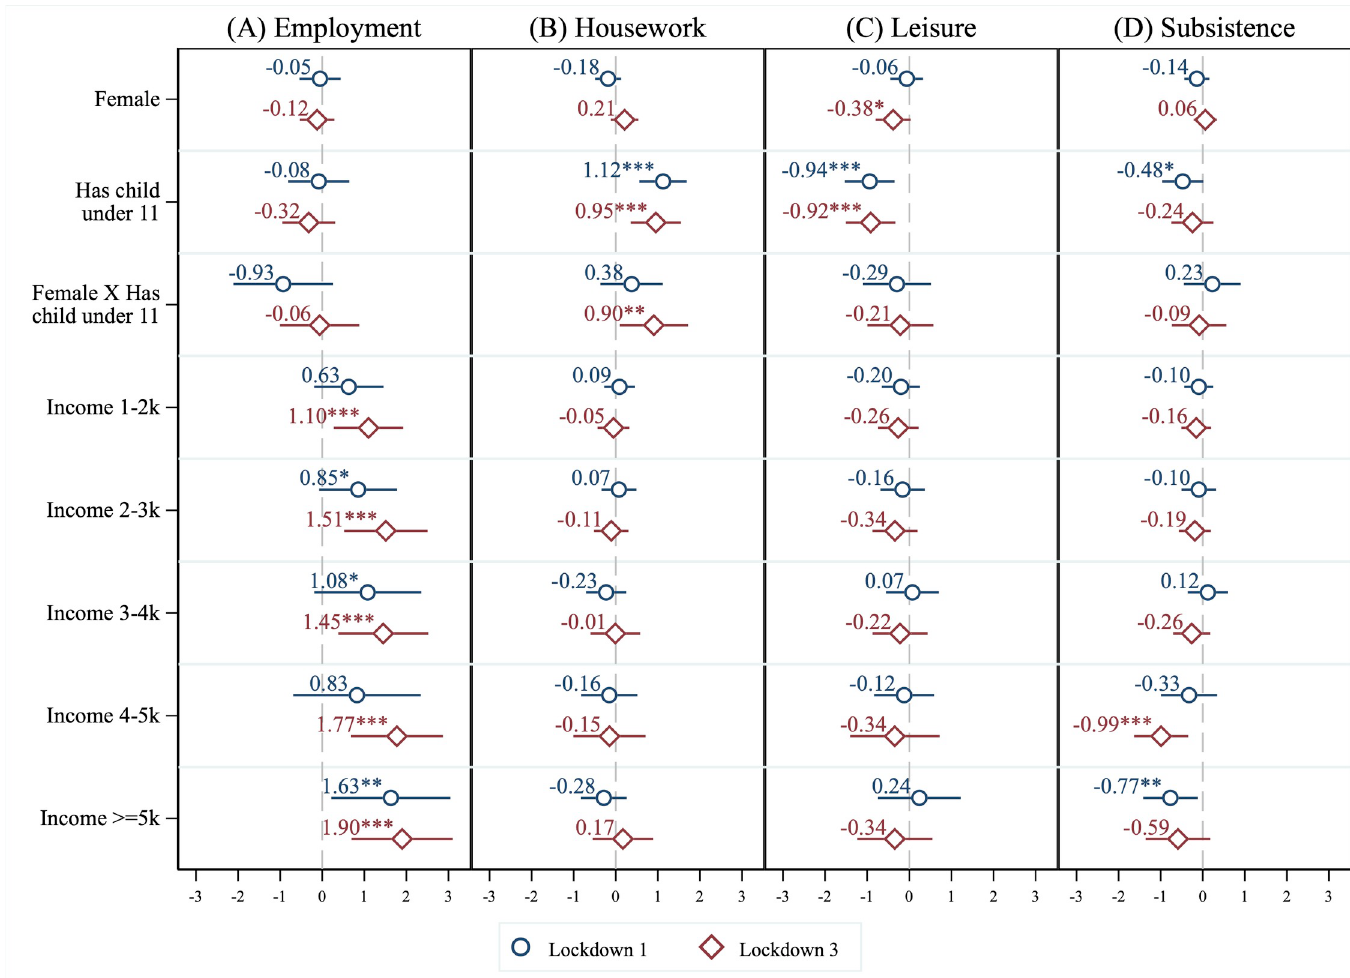
Fig 2. Correlates of time spent (hours per day) on broad activity categories. Lockdown 1 refers to May 2020 and Lockdown 3 refers to March 2021. In addition to the variables reported, we also controlled for age, education, working-from-home status, and pre-pandemic levels in total time spent on the given activity. Regressions with employment as the dependent variable used Heckman corrections to account for selection into employment. Point estimates are reported with 95% confidence intervals. The Heckman corrected regression (panel A) used bootstrapped standard errors (1000 replications); other regressions used robust standard errors (panels B-D). ��� p < 0.01, �� p < 0.05, � p <